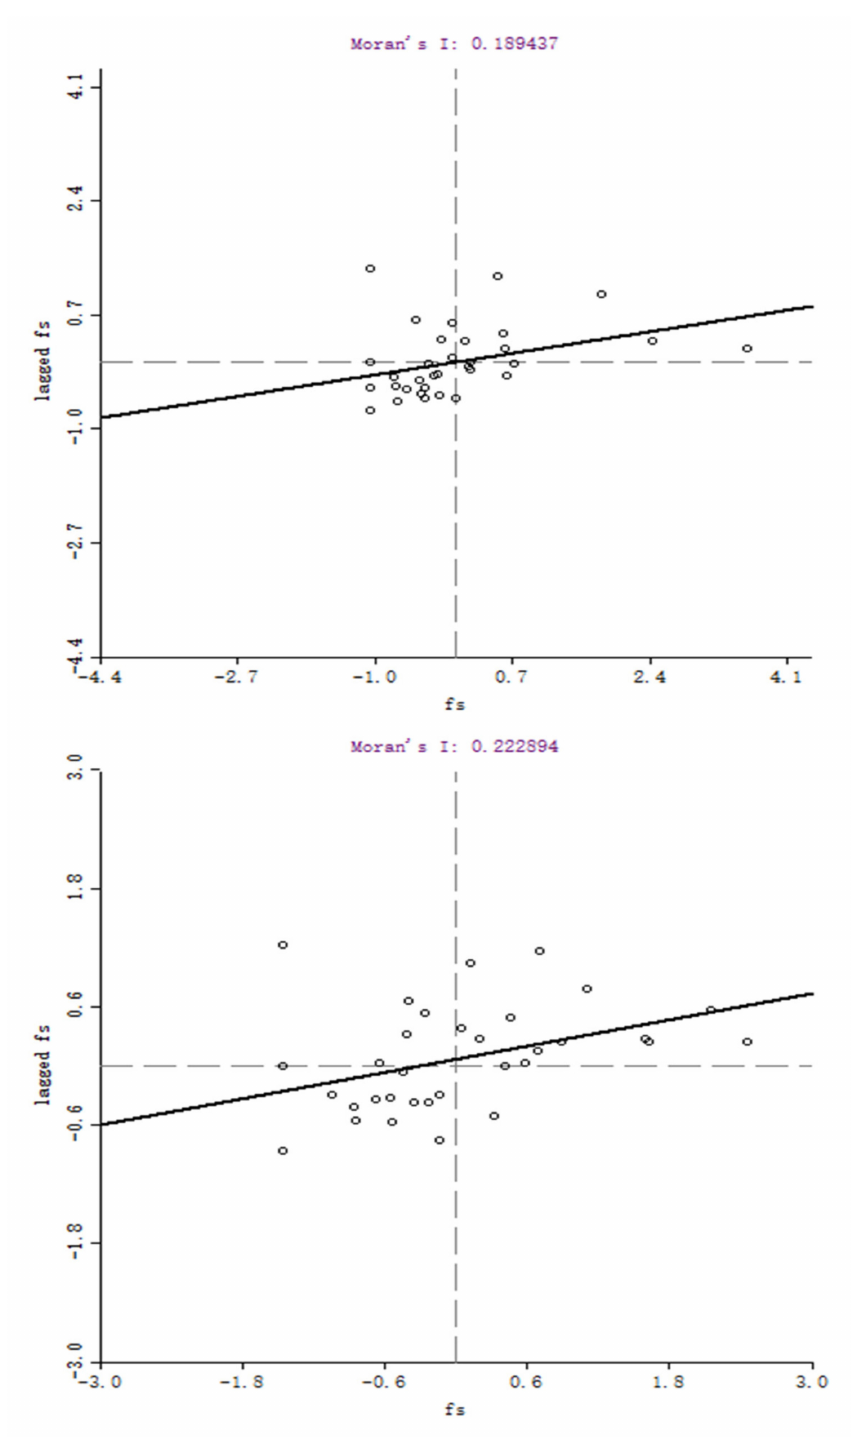
Figure 3. MSP for Chinese provincial FSP based on Geo-weight in 2005 and